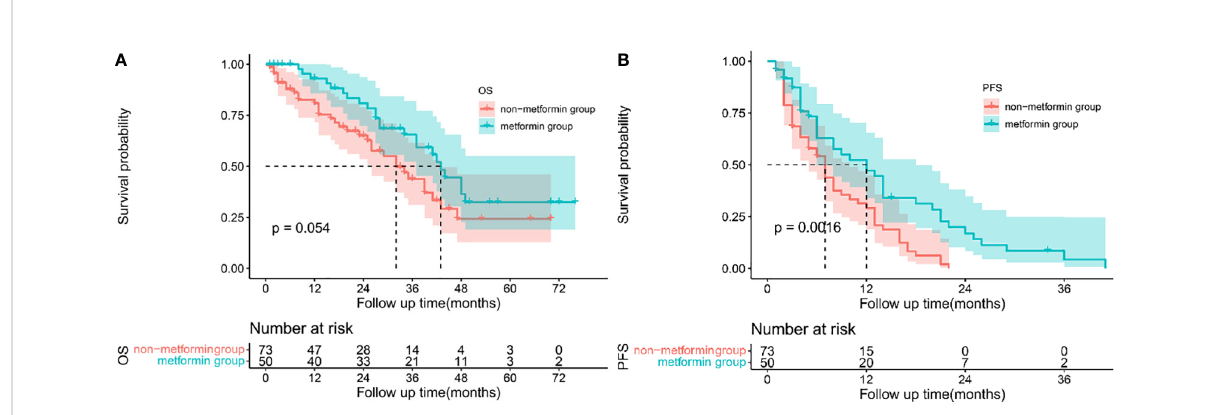
FIGURE 1 Survival analysis: Kaplan-Meier plots comparing metformin users versus non-metformin users among HCC patients with T2DM undergoing TACE. Overall survival (A) and progression-free survival (B) curves in the whole